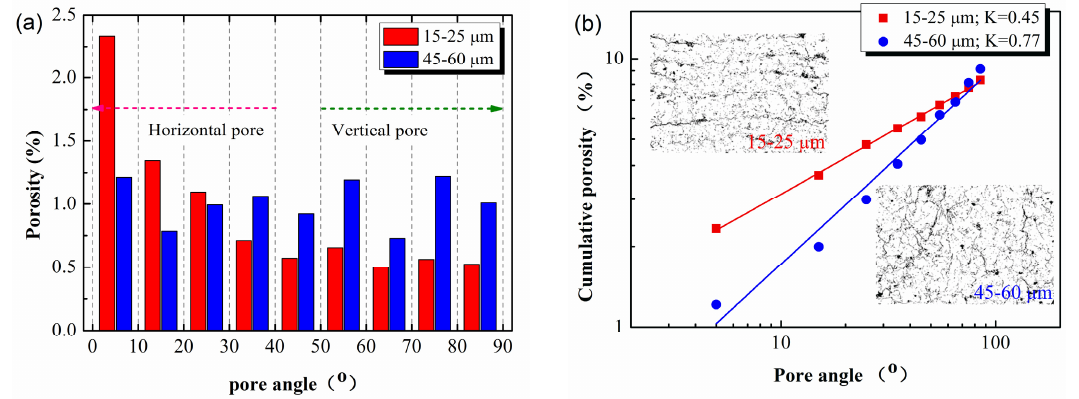
Figure 10. Orientation characteristics of the pore of the two coatings after 20 cycles: ( a ) The distribution of the pore content of the coating with its orientation angle; and ( b ) the change of cumulative pore content in logarithmic coordinates with its orientation angle.